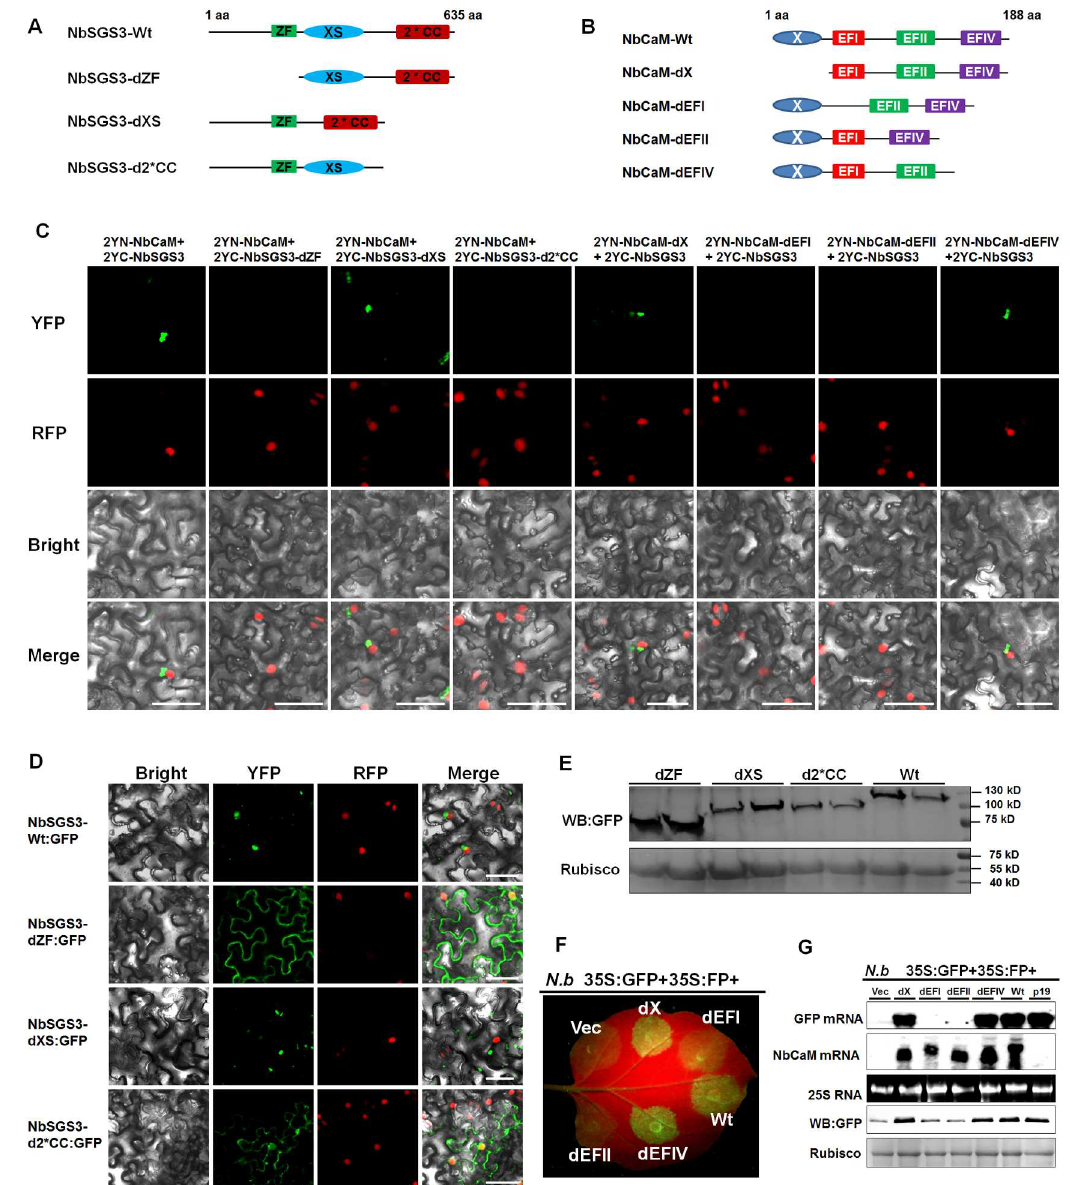
Fig 3. Function of conserved domains in NbCaM and NbSGS3. (A) Schematic representation of wild type NbSGS3 and its deletionderivatives. ZF: zinc finger domain; XS: rice gene X and SGS3 domain;2 * CC: two coiled-coil domains. (B) Schematic representation of wild type NbCaM and its deletionderivatives. X: an unknown domain; EFI: first Ca 2+ binding domain; EFII: second Ca 2+ bindingdomain;EFIV: fourth Ca 2+ bindingdomain. (C) BiFC analysisof NbCaM and NbSGS3. Deletionmutants fused to the N- or C-terminal part of YFP are indicated.Bars represent 50 μ m. (D) Subcellularlocalization of GFP fused to wild type NbSGS3 (NbSGS3-Wt:GFP), ZF (NbSGS3-dZF:GFP), XS (NbSGS3-dXS:GFP), or 2 * CC (NbSGS3-d2 * CC:GFP)deletionmutant. Bars represent50 μ m. (E) Western blot analysisof total protein extracts of samples shown in (D). Ponceau staining of Rubiscolarge subunit is used as a loadingcontrol. (F) GFP fluorescence in leaves of N . benthamiana plants co-infiltratedwith Agrobacterium cultures containing 35S:GFP+35S:FP and either empty control (Vec), the four deletion mutants of NbCaM or wild type NbCaM as indicated.Infiltrated leaves were photographed at 5 dpi under UV light. (G) Analysesof RNA and protein levels in the agroinfiltrated leaf samples shownin (F). TBSV p19 was used as a positive control for silencingsuppression.